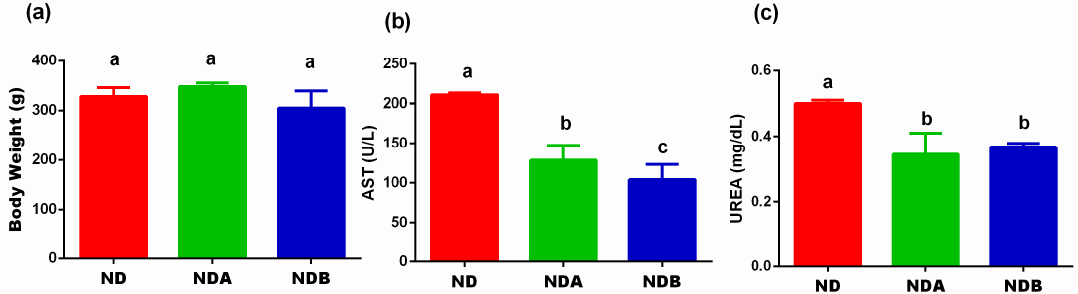
Figure 2. Effects of urolithins on body weight and organ function. Final body weight ( a ), AST. ( b ), Urea ( c ). a,b,c Data are expressed as mean ± SE ( n = 6). Mean values bearing different letters are significantly different ( p < 0.05).